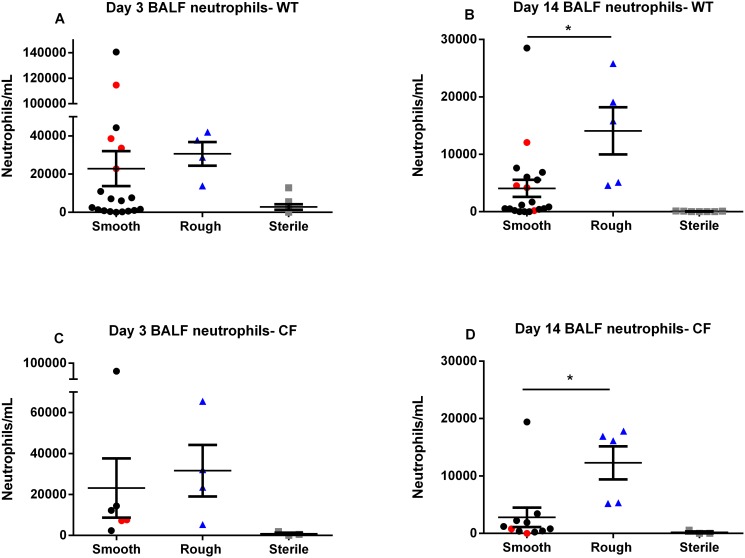
BALF neutrophils.(A, B, C and D) Inoculation with rough morphotype causes greater BALF neutrophilia than smooth morphotype at 14 days post-inoculation in both WT (B) and CF (D) mice. Red circles indicate smooth morphotype inoculation with conversion to rough morphotype. Minimal BALF neutrophilia was seen after sterile thrombin/fibrinogen inoculation. (N = 4–20 mice in each M. abscessus group, N = 3–8 mice in each sterile group). * p< 0.05. Data displayed as mean ± SEM of group, pooled from 2–3 replicate experiments for each morphotype.